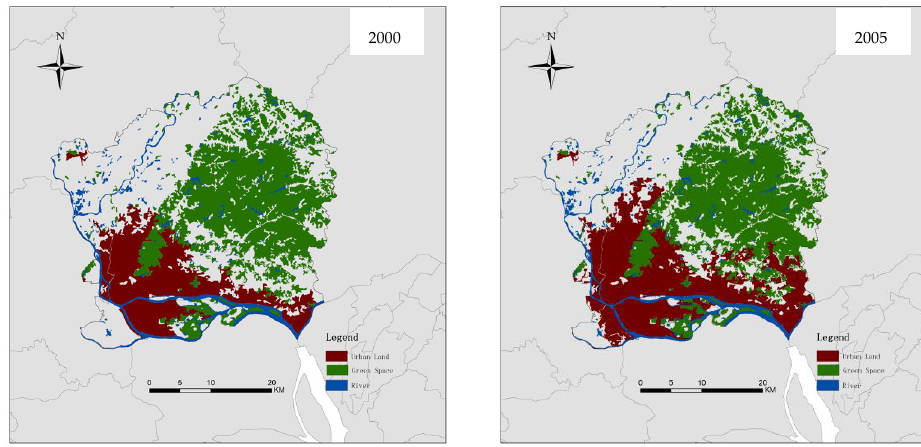
Figure 11. Urban expansion from 2000 to 2005. (Source: drawn by the authors).